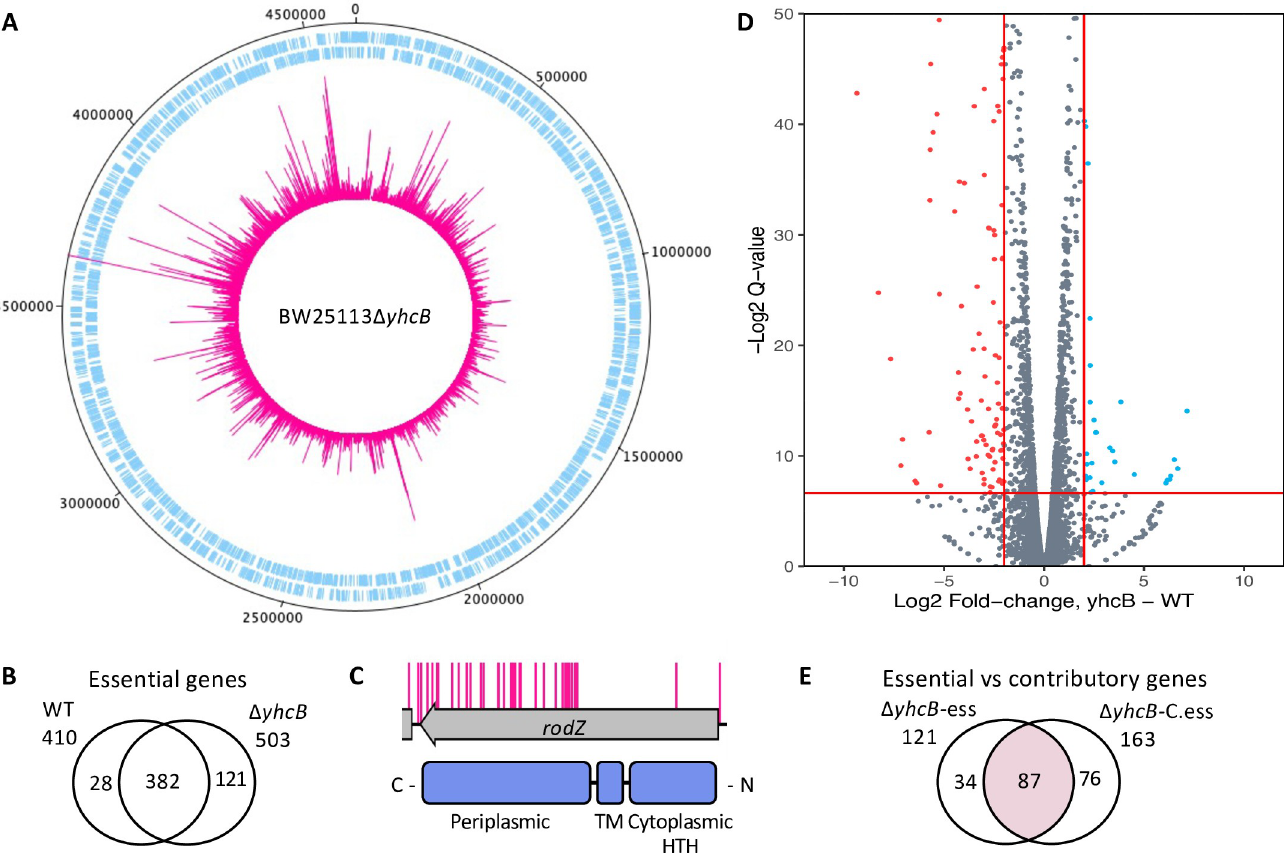
Fig 4. Construction of a transposon library in a yhcB mutant and identification of genes with a synthetic lethal relationship with yhcB . (A) The Δ yhcB transposon library. A genome map of BW25113 starting at the annotation origin with the sense and antisense coding sequences of BW25113 shown in blue, respectively, and the position and frequency of sequenced transposon insertion events shown in pink. (B) Comparison of genes identified by bimodal analysis as significantly underrepresented by transposon mutants in each library. (C) The insertion profile of rodZ in the Δ yhcB library, with RodZ domains shown below in blue. (D) The log 2 fold-change of read depth per gene between the parent BW25113 and the Δ yhcB transposon library. Genes enriched for transposon insertions ( > 2-fold) in the yhcB library are shown in blue, indicative of more fit mutants. Genes with a > 2-fold decrease in insertions are shown in red, indicative of sick mutants. A Q-value threshold of 0.01 was used (red horizontal line) (E) Comparison of genes predicted to be essential (sparsely disrupted genes) with genes identified as having a > 2-fold decrease in reads compared to the control library (genes that contribute to fitness). This is a comparison of the bi-modal and enrichment analyses outputs. The overlap of these analyses are the 87 identified synthetic lethal genes (pink). Abbreviations: wild-type (WT); transmembrane domain (TM); helix-turn-helix domain (HTH).